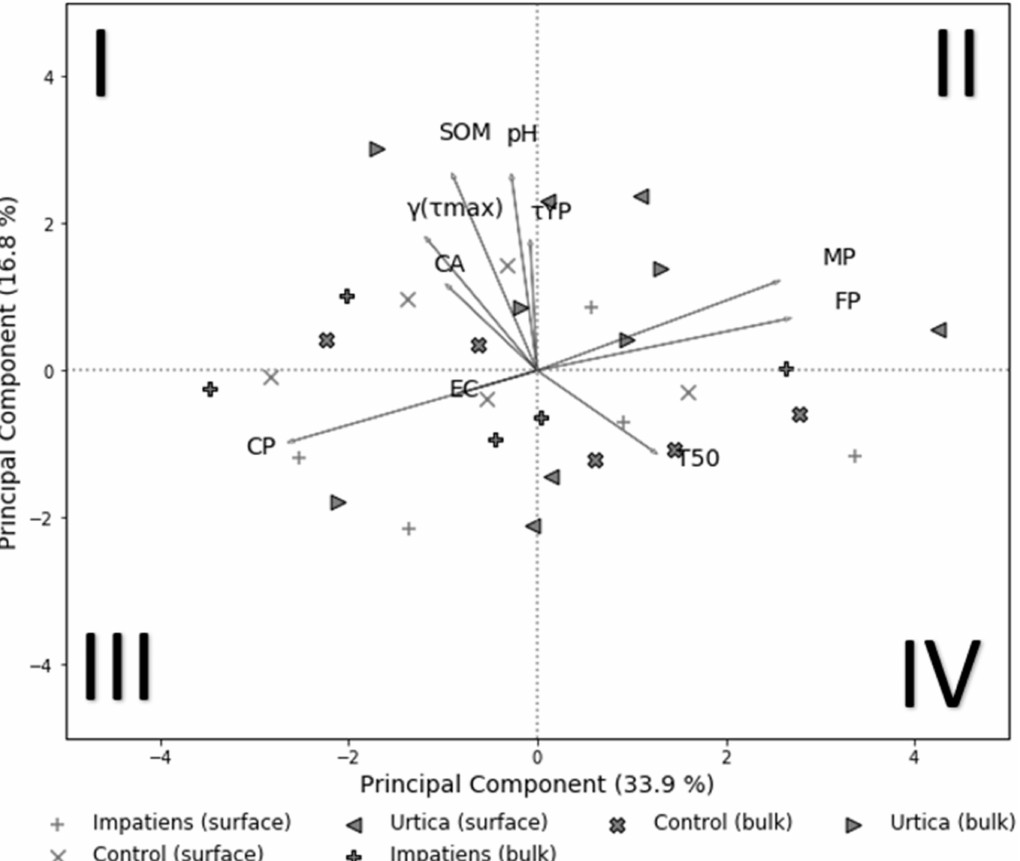
Figure 8. Principal Component Analysis (PCA) of parameters of surface (0–2 cm) and bulk layers (2–5 cm depth) of soil colonized by Impatiens glandulifera ( I. glandulifera ) and by Urtica dioica ( U. doica ) or of bare soil (Control). Displayed are relationships between total soil organic matter (SOM /%), thermal recalcitrance (T50/ ◦ C), soil hydraulic properties expressed as coarse (CP), medium (MP) and fine pores (FP/%) at the field capacity, wettability expressed as contaqct angle (CA/ ◦ ), electrical conductivity (EC/ µ S · cm − 1 ), soil pH (pH), and soil structural stability expressed as shear stress at yield point ( τ YP/Pa) and shear strain at the end of the viscoelastic range ( γ ( τ max)/%). Quadrants of the projected coordinate system are given by roman